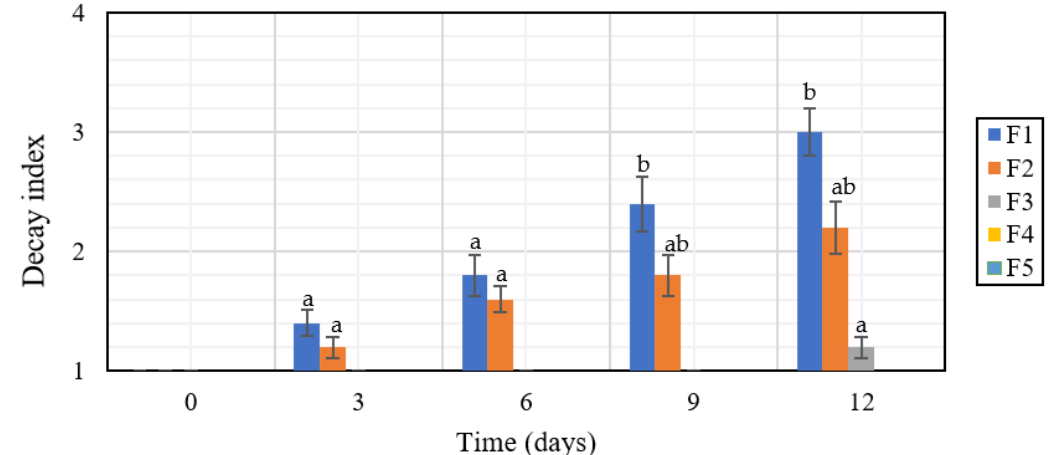
Figure 4. Decay index in S. lycopersicum with CS + RGEO coatings stored for 12 days at 4 ± 2 °C. F1 = Control; F2 = CS; F3 = CS + RGEO 0.5%; F4 = CS + RGEO 1.0%; F5 = CS + RGEO 1.5%. Mean values and intervals of LSD 95% according to the ANOVA test. The superscript letter (a–b) refers to the significant differences ( p < 0.05) between each treatment.